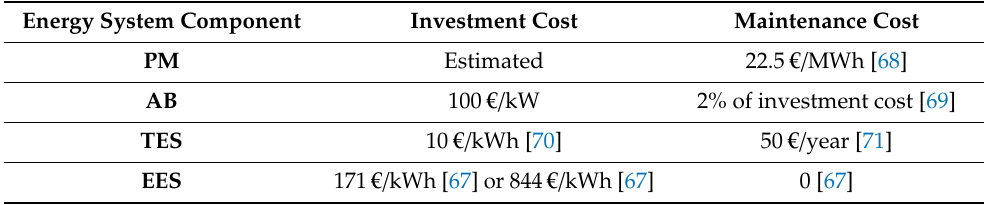
Table 6. Assumptions for the feasibility analysis.